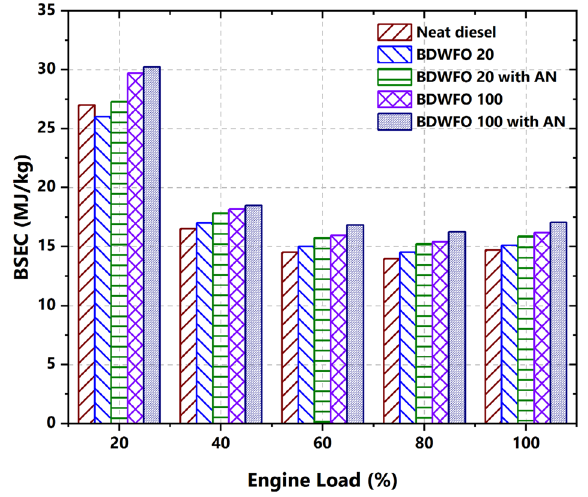
Figure 4. Brake specific energy consumption—BSEC (MJ/kW h) on various loads of engine (%).